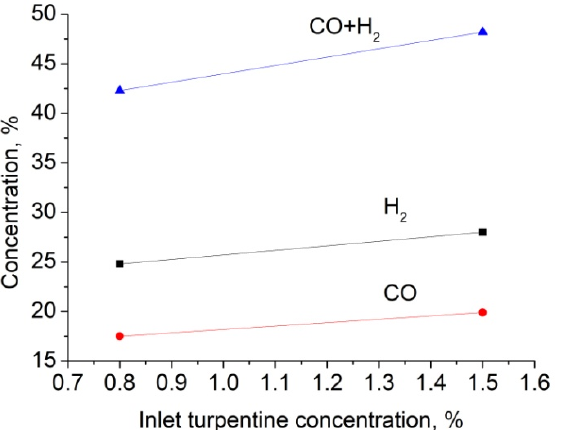
Figure 12. Dependence of products concentration on turpentine content in feed 20% NG +21% O 2 +N 2 +turpentine oil in the process of autothermal reforming in the radial reactor with the heat exchanger. Flow rate 2.5 m 3 /h, LaNi(Pt)O 3 /La 0.1 Ce 0.45 Zr 0.45 O 2 active component.